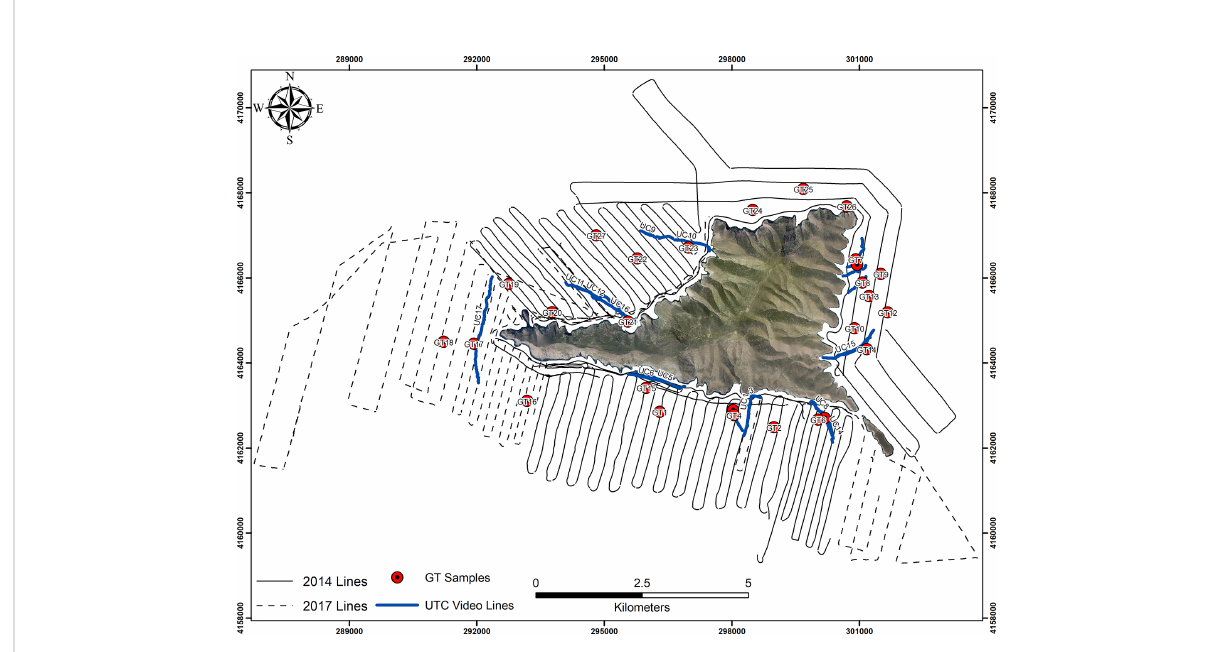
FIGURE 2 Map of the remote sensing and underwater video track lines and ground-truthing sample